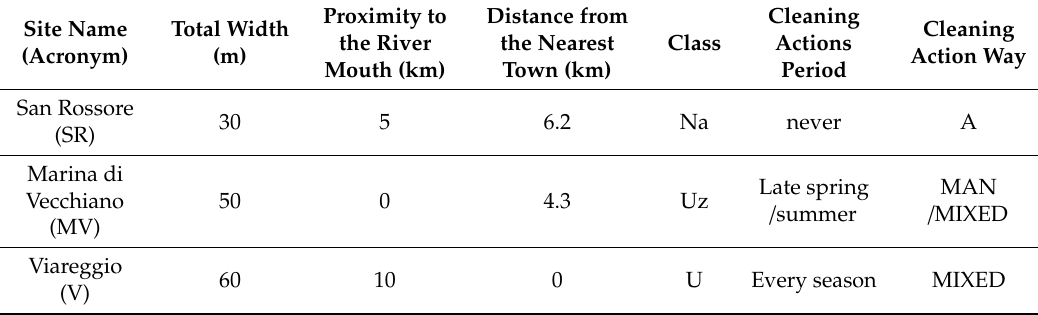
Table 1. Selected characteristics of the sites: width of the beach (distance sea-dune) (m); proximity to the river mouth (Km); distance from the nearest town (km); level of anthropization (U = Urban, Uz = Urbanized, Na = Natural); type of cleaning: A absent, MAN manual, MIXED mechanized / manual. Images (polygons) and the relative GPS coordinates identifying the selected stretch of beach in each site are reported in Figure S2, Supplementary